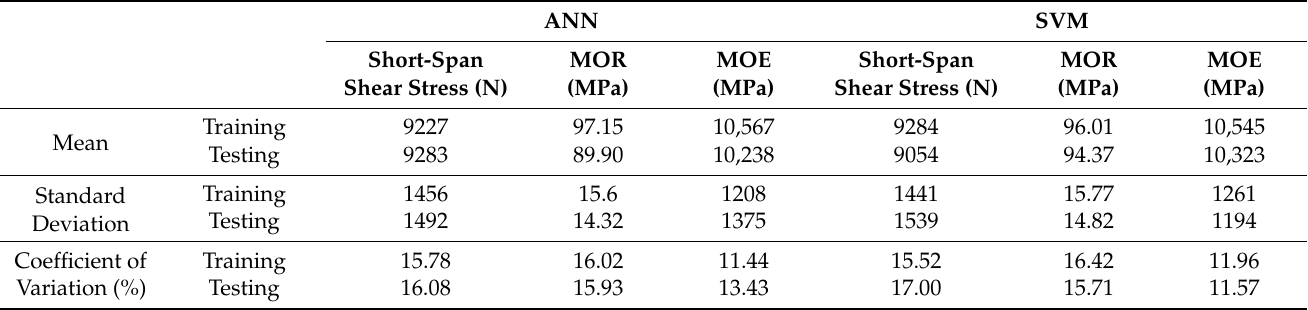
Table 1. Statistical analysis of mechanical properties.